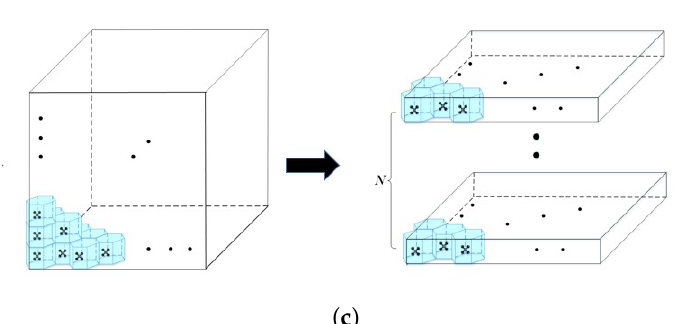
Figure 1. Coverage sampling design. ( a ) Basic decomposition unit. ( b ) Distribution of sampling points in a subspace. The red solid line represents the outline of the study area A. The yellow dot is the sampling point. ( c ) Space